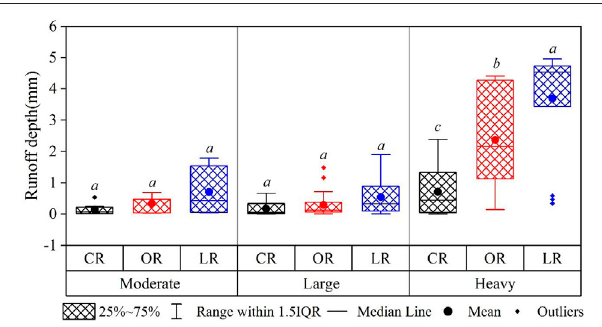
FIGURE 10 | Runoff depth of CR, OR, and LR under different rainfall patterns, and boxes labeled with different letters within groups indicate signi fi cant differences at p < 0.05. CR, OR, and LR represent cross-ridge tillage, oblique-ridge tillage, and longitudinal-ridge tillage, respectively. Moderate, large, and heavy represent moderate, large, and heavy rainfall patterns, respectively.